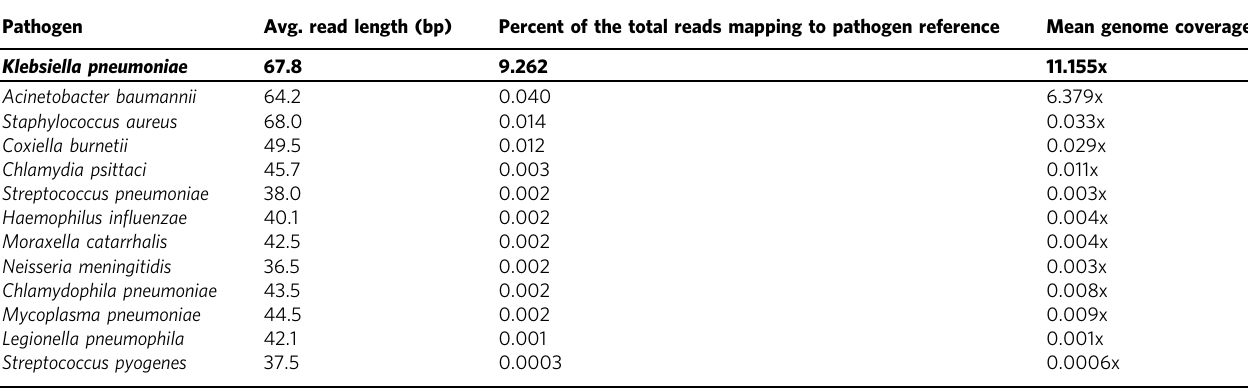
Sorted by descending percent of reads mapping, bolded and boxed text indicates the highest mapping pathogen (see table S6 for